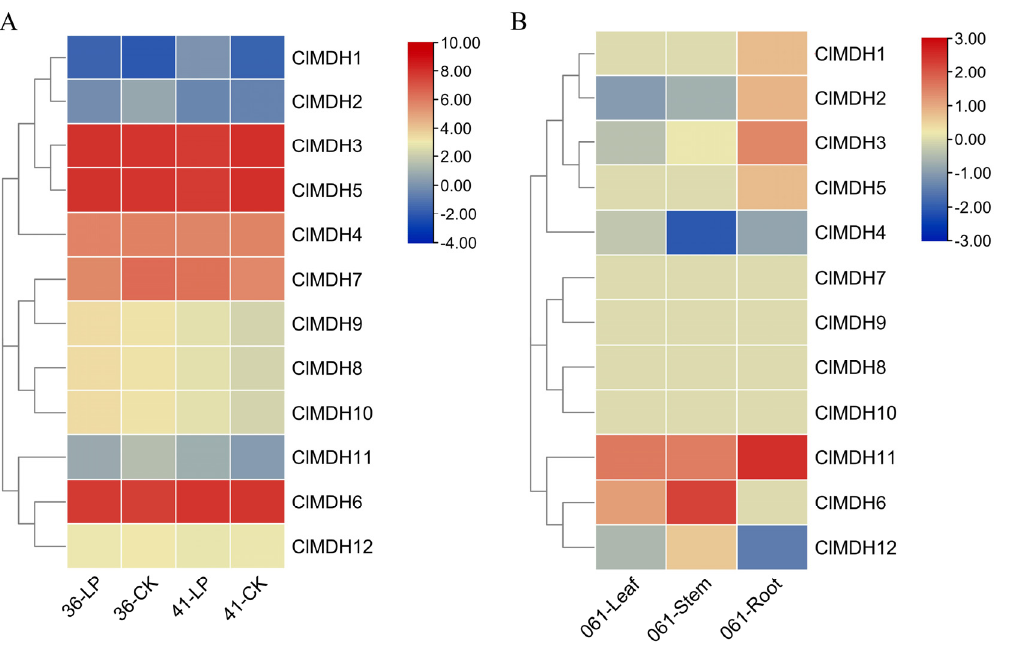
Figure 9. Heatmap showing the expression profiles of ClMDH genes in root, stem and leaf tissues of clones 36, 41 and 061 of Chinese fir cultivars under different conditions. ( A ) Expression of ClMDH genes in the root of clones 36 and 41 of Chinese fir. The LP and CK indicate the low-phosphorus stress (LP) and control (CK) conditions. ( B ) Expression of ClMDH genes in the root, leaf and stem of clone 061 of Chinese fir. Fragments per kilobase per million (FPKM) values of ClMDH genes in all tissues and conditions were transformed by log2 and a heatmap was constructed by TBtools software (the red color shows the highest and the blue color shows the lowest expression levels in the expression bar).